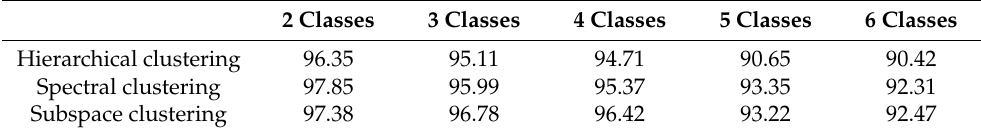
Table 8. Results of the clustering methodology with deep learning LSTM.